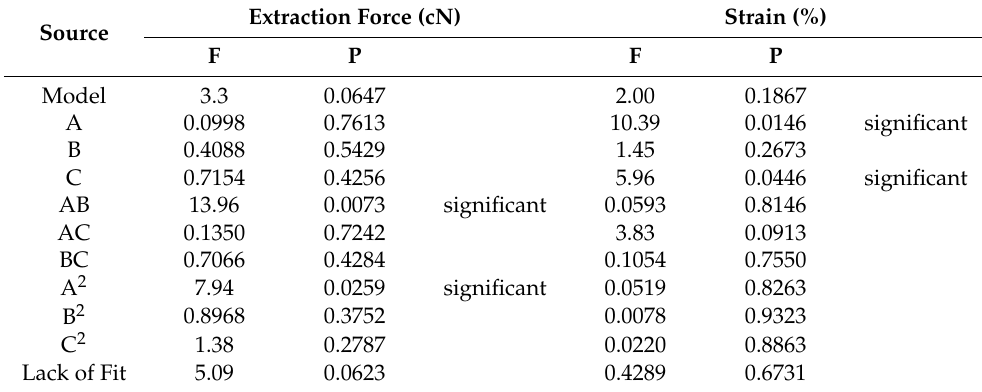
Table 3. ANOVA results of responses for plasma treated polyimide